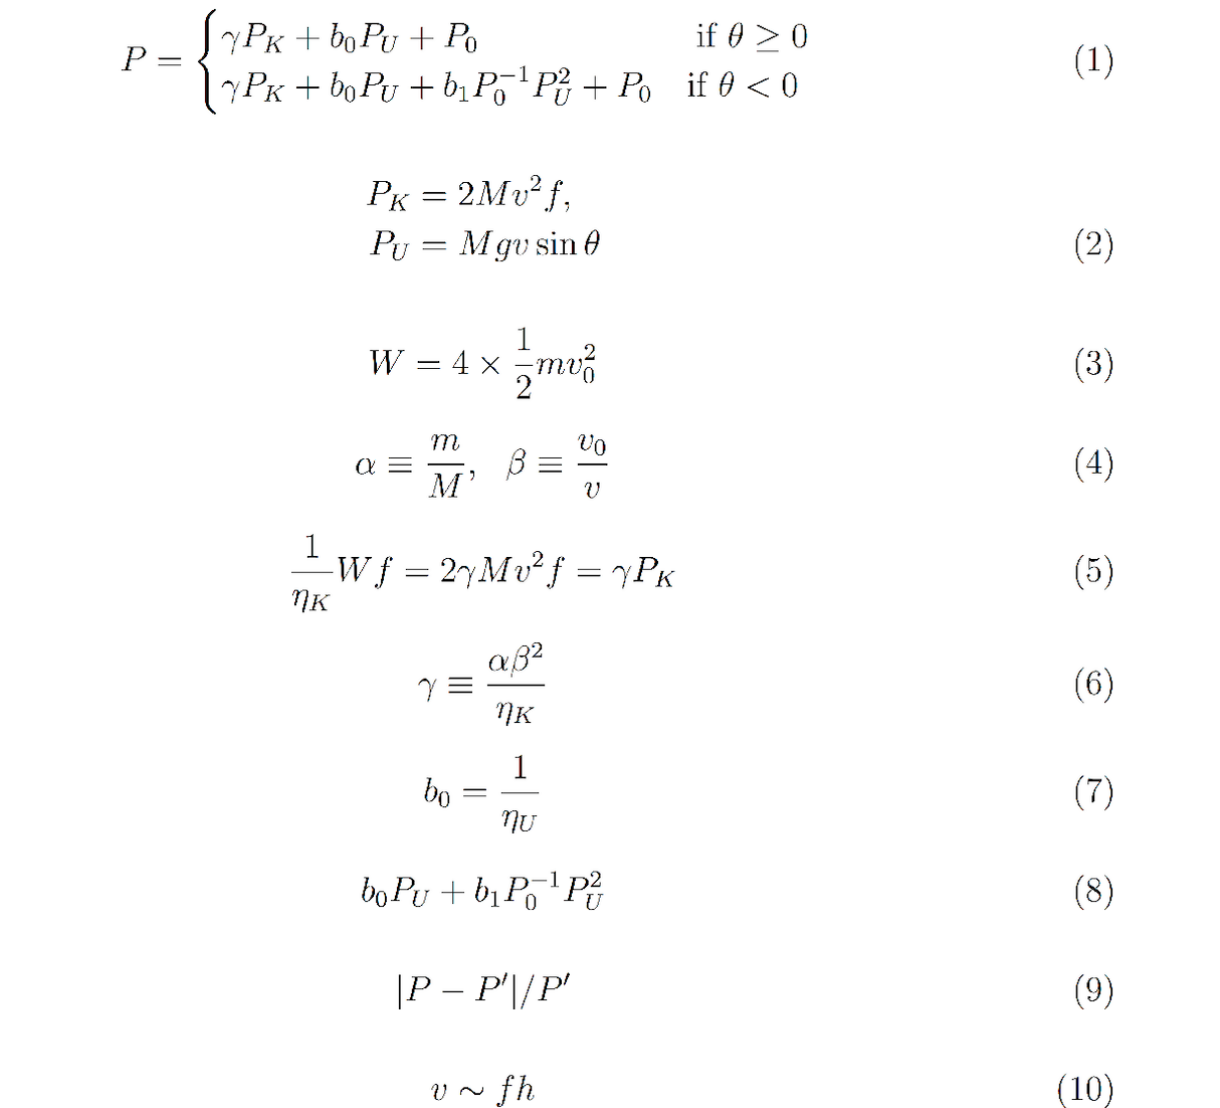
Figure 4. List of equations of the model of energy expenditure during